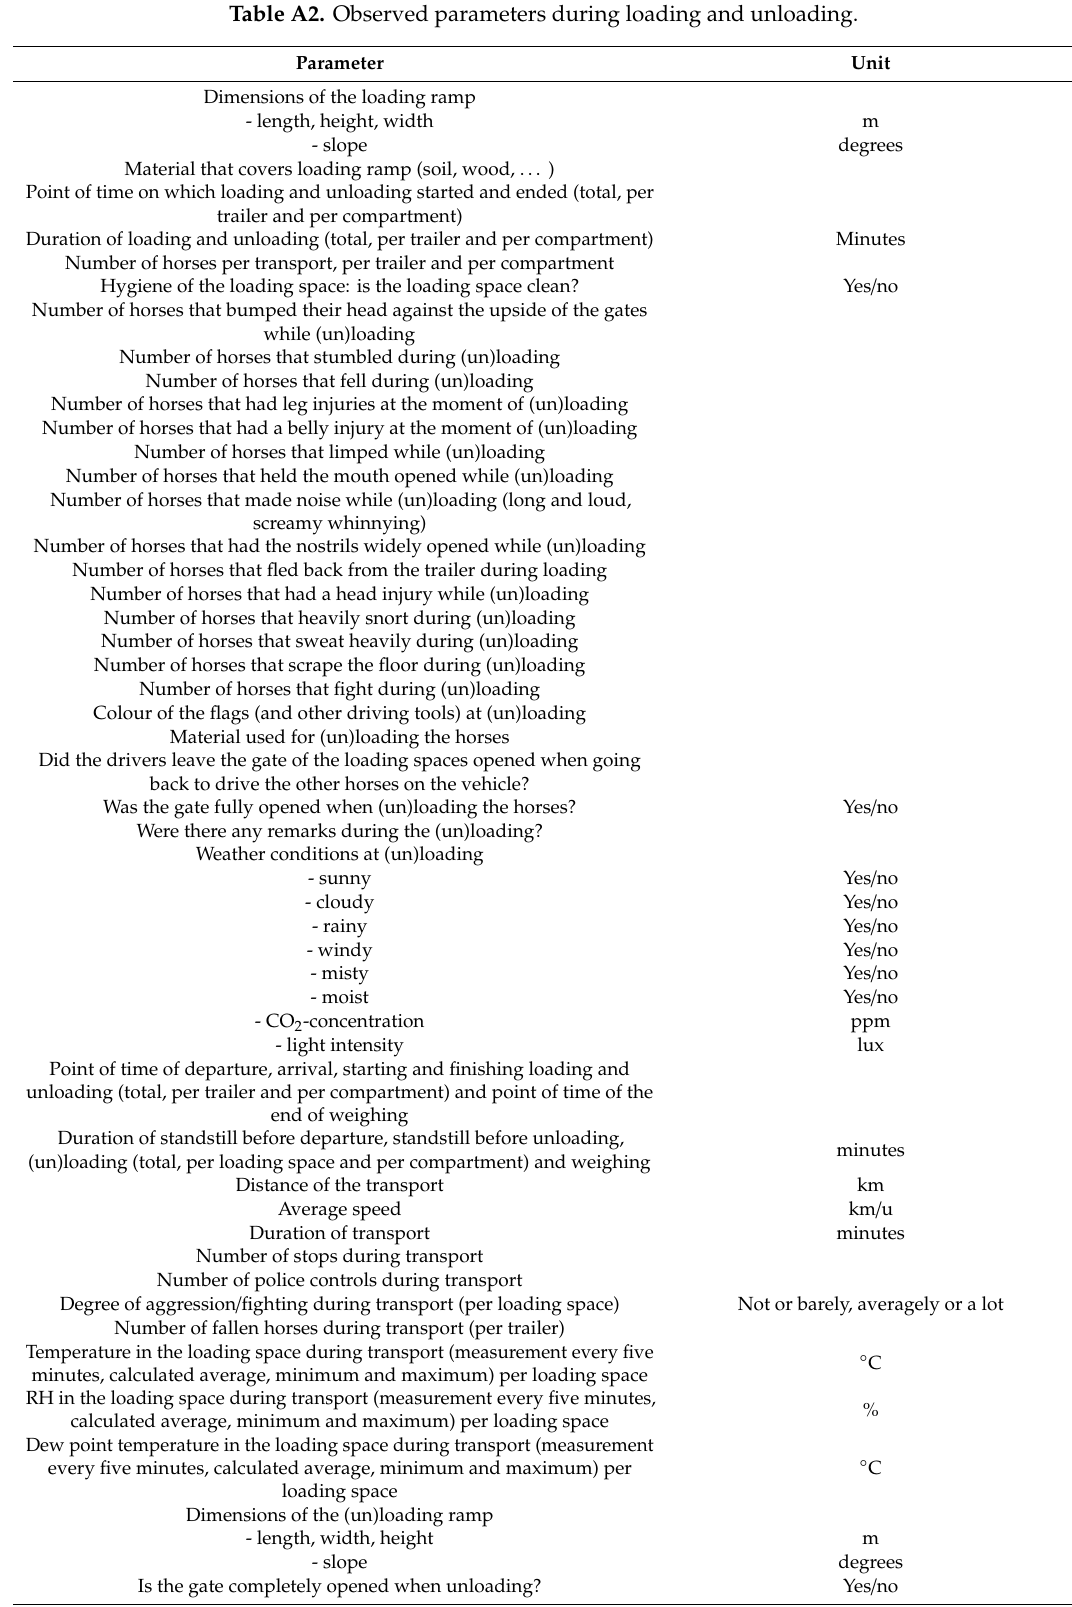
Table A2. Observed parameters during loading and